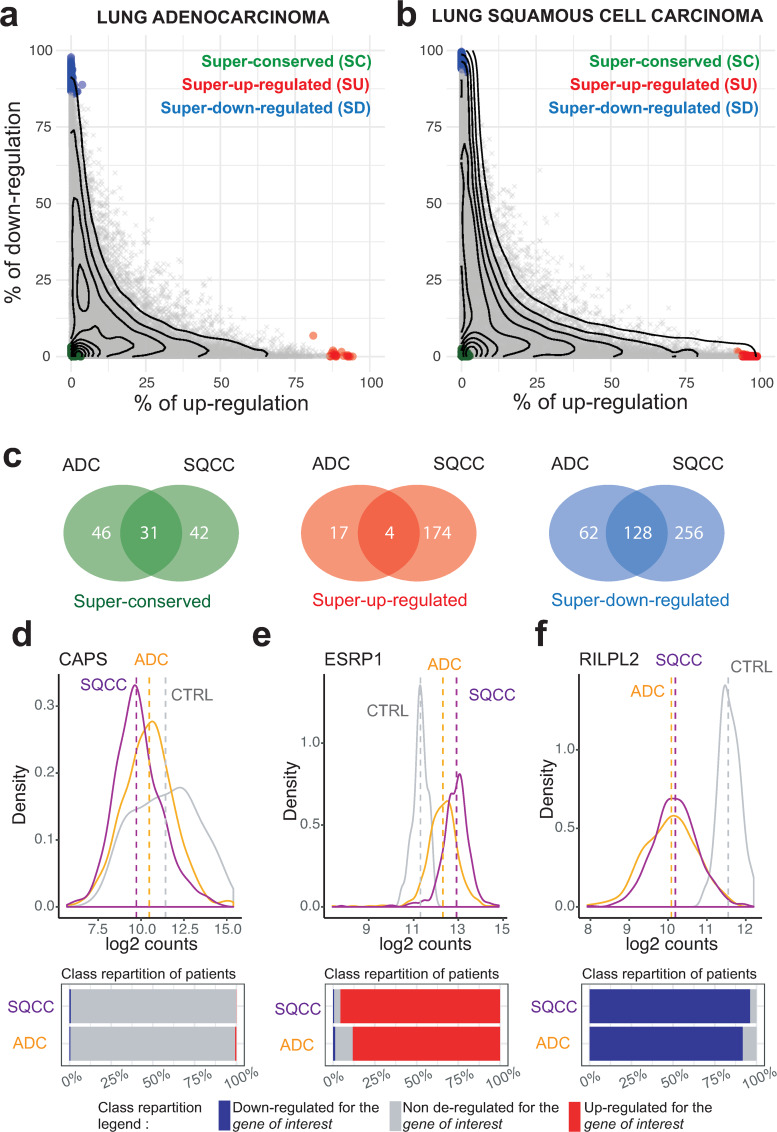
The gene deregulation pattern.(a-b) Scatterplots of the percentage of up-regulated versus down-regulated patients in the ADC (left panel) and SQCC (right panel) cohorts. Each dot corresponds to one gene. The x-axis indicates the percentage of up-regulation within the cohort, the y-axis indicates the percentage of down-regulation within the cohort. The contour lines correspond to the density of genes. Genes that are significantly differentially expressed at the individual level (t-statistic, q-value < 0.05) are represented using the following color code: green genes are super-conserved (SC), blue genes are super-down-regulated (SD), red genes are super-up-regulated (SU), other genes are depicted in gray. (C) Venn diagrams indicating the total number of SC, SU and SD genes in ADC and SQCC cohorts. (d-e-f) (Top panels) Distributions of gene expression levels (normalized counts) for three representative genes (the SC gene CAPS in (d), the SU gene ESPRP1 in (e), the SD gene RILPL2 in (f)) in the ADC cohort (yellow), in the SQCC cohort (purple), and for the control patients (gray). The dashed lines represent the mean expressions. (Bottom panels) The corresponding percentages of patients deregulated for each shown gene in ADC and SQCC cohorts are represented by bar plots: gray for non-deregulated patients, blue for down-regulated patients and red for up-regulation patients.